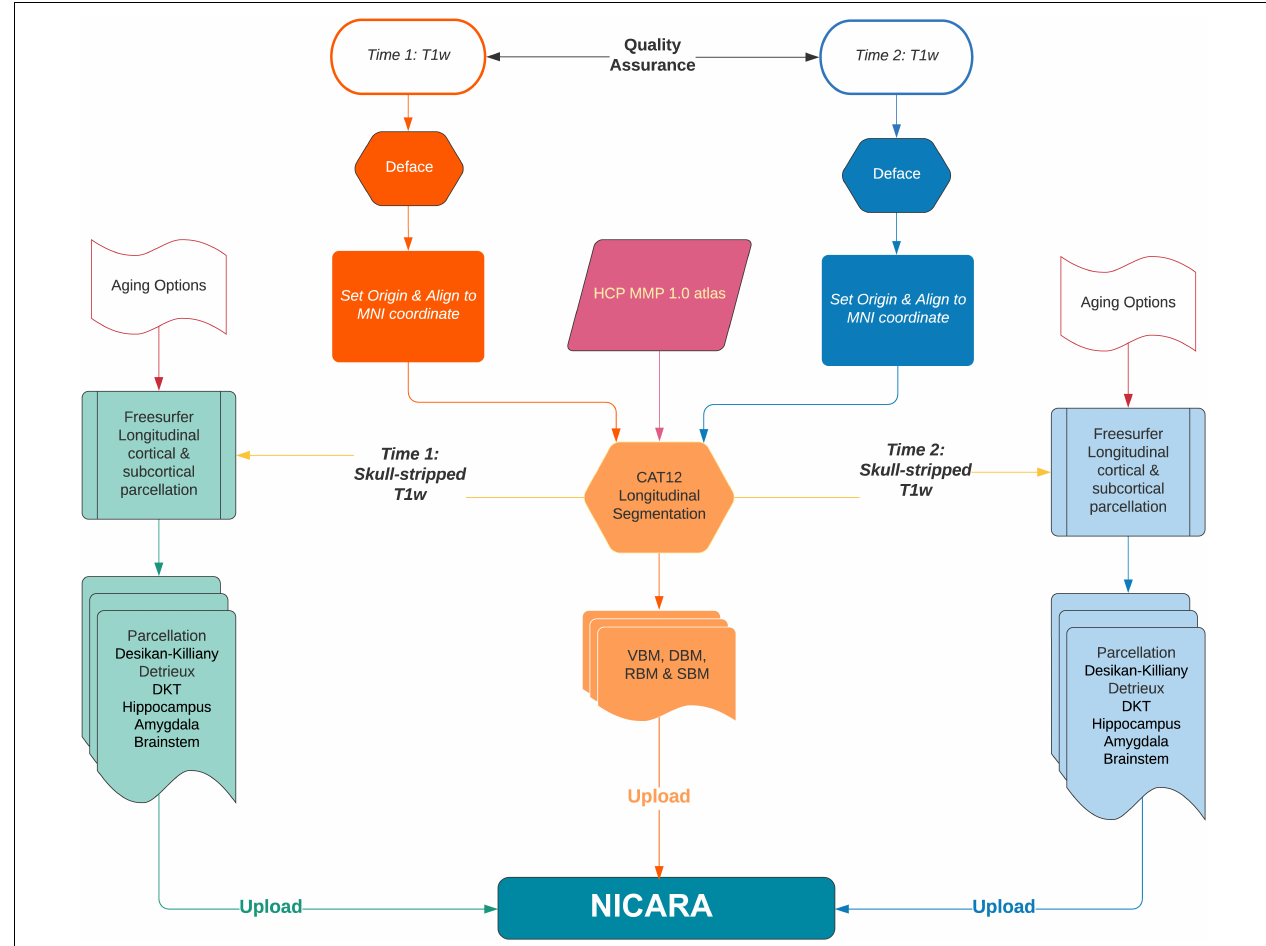
FIGURE 1 | The flowchart of NICARA morphometry longitudinal pipeline processes making use of FreeSurfer, CAT12 toolbox and NICARA.